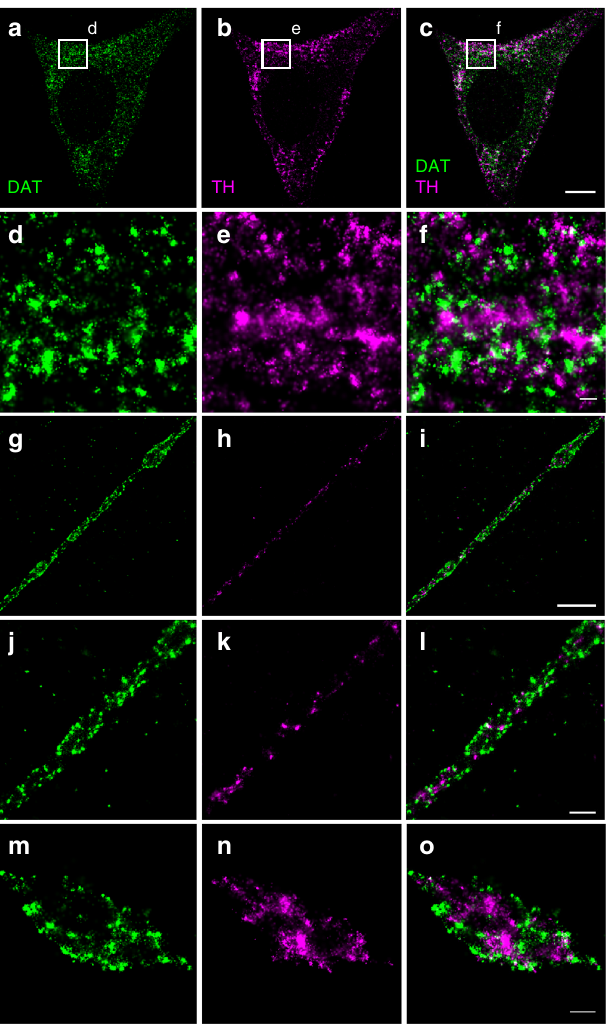
Fig. 6 Cross-section through the cell body, extensions and varicosities of dopaminergic neurons showing by dual-color dSTORM imaging the distinct distribution of tyrosine hydroxylase (TH) compared to DAT. DAT was visualized by immunolabeling and Alexa647-conjugated secondary antibody. TH was visualized by immunolabeling and CF568-conjugated secondary antibody. a Somatic distribution of DAT. b Somatic distribution of TH. c Merged image of a and b . d – f Enlarged STORM images corresponding to the boxes shown in a – c . g Distribution of DAT in extension with varicosity. h Distribution of TH in extension with varicosity. i Merged image of g and h . j Distribution of DAT in extension. k Distribution of TH in extension. l Merged image of j and k . m Distribution of DAT in varicosity. n Distribution of TH in varicosity. o Merge image of m and n .